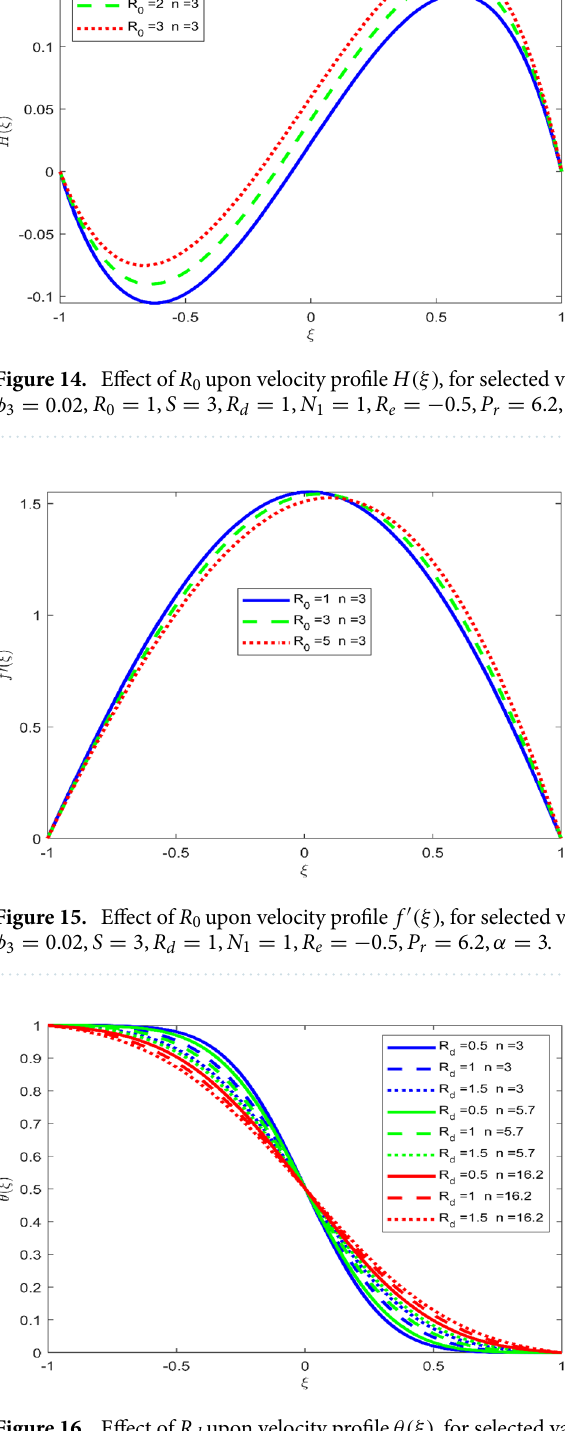
1, S 3, N 1 1, R 0.5, P 6.2, α 3 e = − r = = = = =